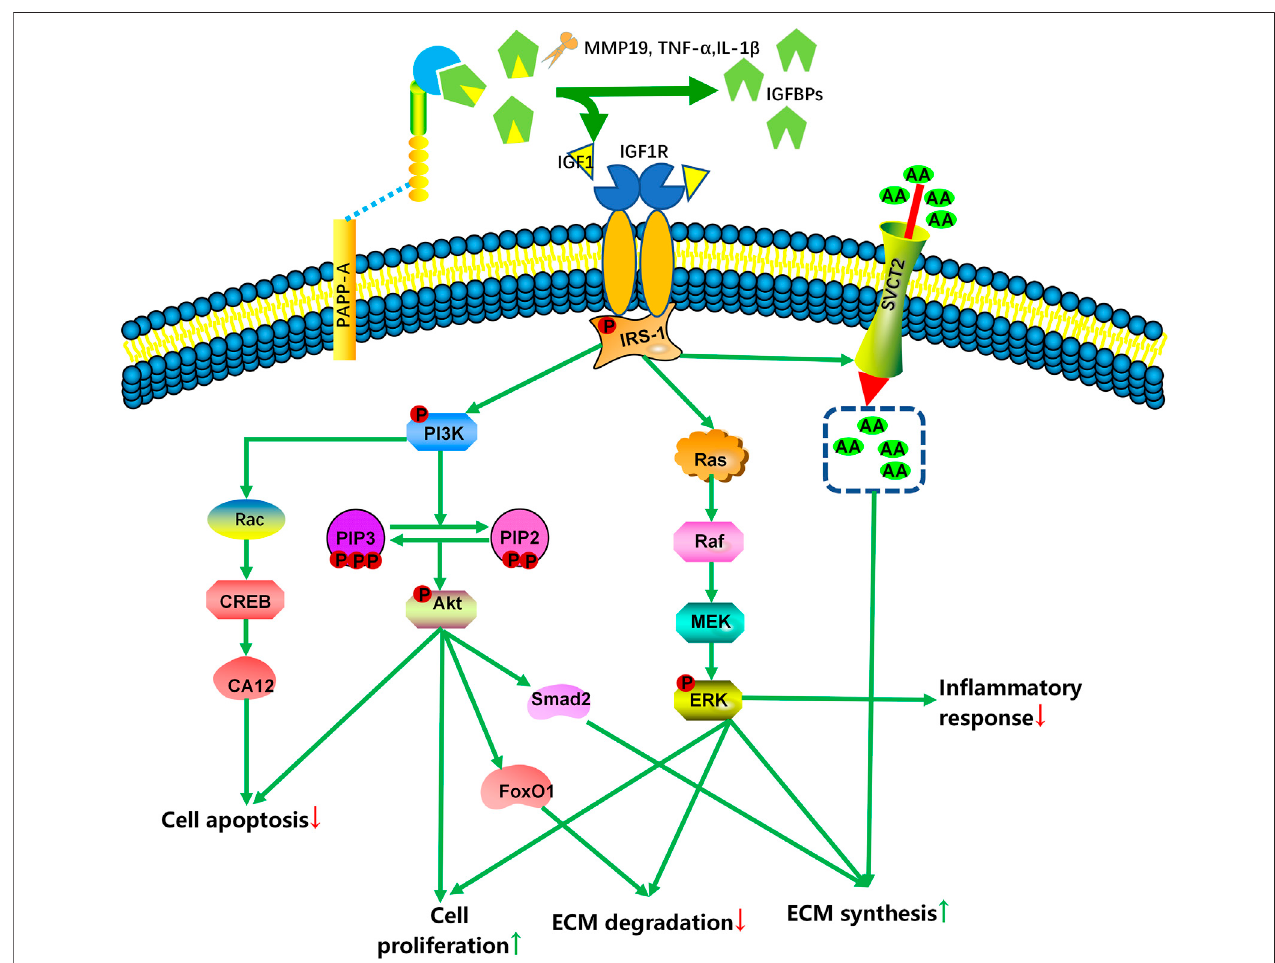
FIGURE1 | Simpli fi ed scheme ofIGF signaling in theintervertebral disc. With theparticipation ofMMPs, TNF α , or IL-1 β ,PAPP-A cleaves IGFBP inthe extracellular matrix, increasing the amount of bioavailable IGF1 and IGF2. To exert their effects, IGF bind to speci fi c cell surface receptors (IGF1R and IGF2R). IGF1R activation activates various molecular signaling pathways, including the PI3K-Akt and RAS-extracellular signal-regulated kinase (ERK) pathways, to regulate IVD cell death and ECM content.MMP: matrix metalloproteinases; PAPP-A: pregnancy-associated plasma protein-A; IRS-1: insulin-receptor substrate 1;AA: ascorbic acid; SVCT2: sodium-dependent vitamin C transporter 2; PI3K: phosphatidiyl inositol 3 kinase; PIP: phosphatidylinositol-3,4,5-trisphosphate; FoxO1: forkhead box O1; CREB: cAMP-responsive element-binding protein; CA12: carbonic anhydrase 12; MEK: mitogen-activated protein kinase/extracellular signal-regulated kinase; ERK: extracellular signal-regulated